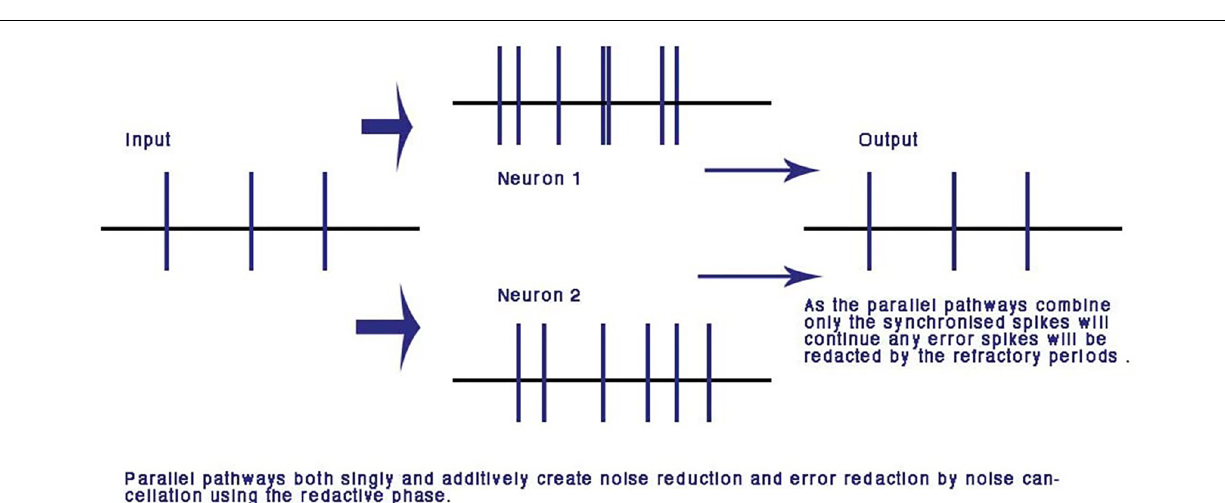
FIGURE 4 | Computation by phase ternary interactions – Collisions from CAPs may result in nullification of CAP (second row) depending upon phase and the dynamics of the membrane at the point of collision. Multiple collisions form patterns navigating pathways through the network. Action potentials firing in-phase map together, whilst those with +1 and –1t overlapping cancel to 0.